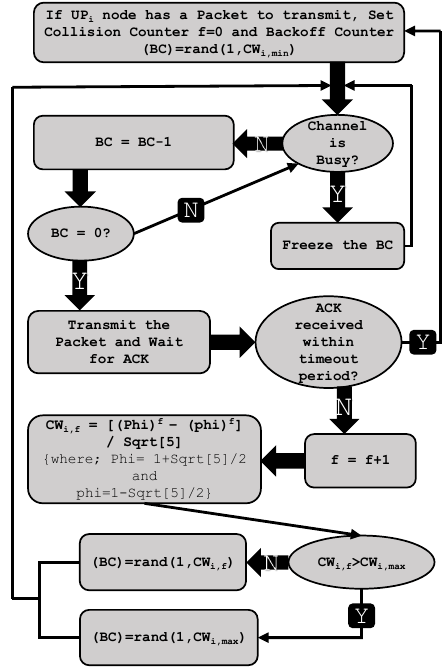
Figure 8. PFB-based IEEE 802.15.6 CSMA/CA procedure.